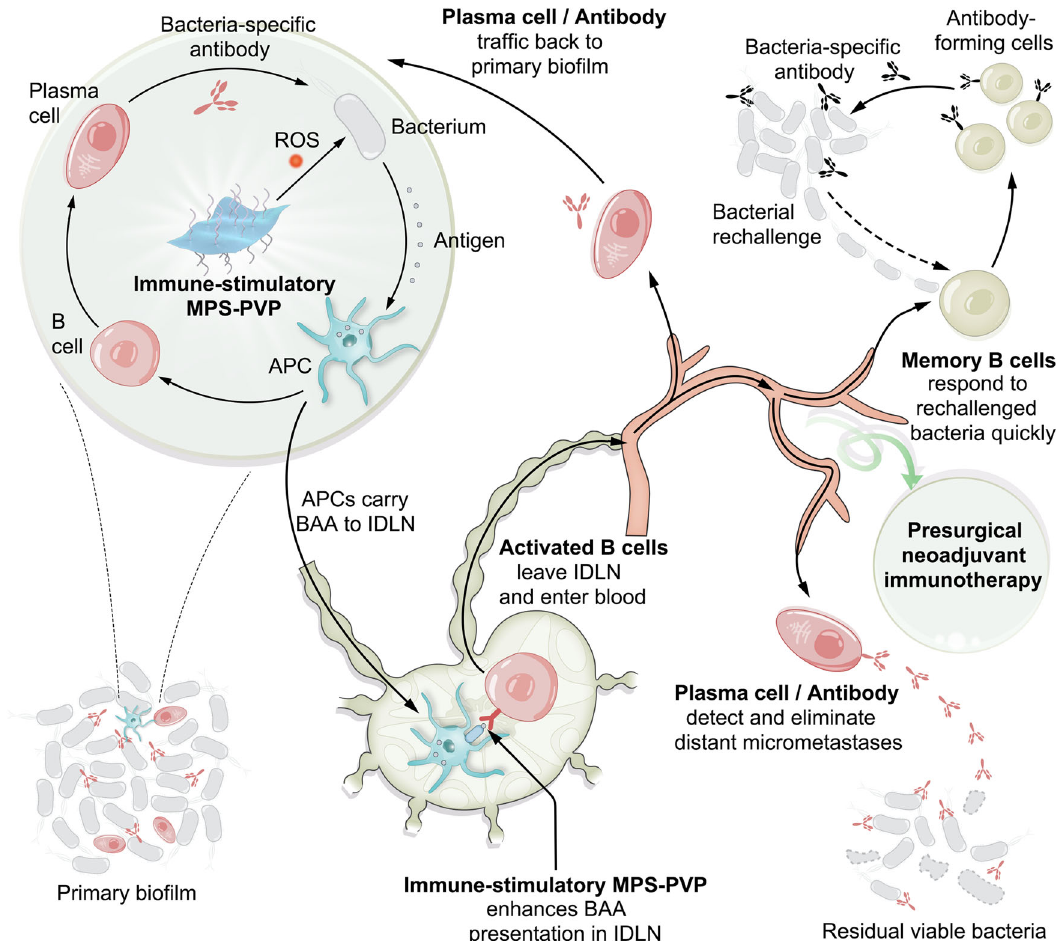
Fig. 1 | Schematic illustration of immune-stimulatory MPS-PVP for eliciting anti-bio fi lm humoral immunity and achieving presurgical neoadjuvant immunotherapy. Immune-stimulatory MPS-PVP leads to “ in situ ” expansion of bacterial-speci fi c B cells and antibodies in primary bio fi lm (left). MPS induces bacterial-associated antigens (BAA) expression by producing ROS via Fenton-like reaction. Antigen-presenting cells (APC) pick up and process the BAAs for further presentation. Bio fi lm-in fi ltrating B cells would be primed then and matured into plasma cells for bacteria-speci fi c antibody production. Immune-stimulatory MPS- PVP facilitates and ampli fi es these immune responses. Besides, BAA-containing APCstraf fi ctoinfection-draininglymphnodes(IDLN),wheretheypresentantigens